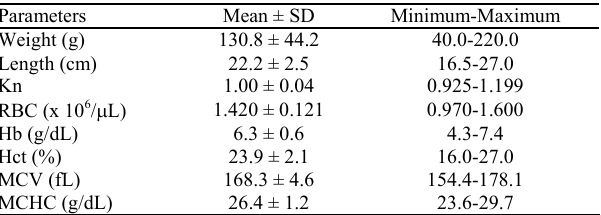
Table 1. Mean values ± Standard deviation (SD), and minimum and maximum for biometric and blood parameters of C . temensis (n = 40) farmed in central Amazon.